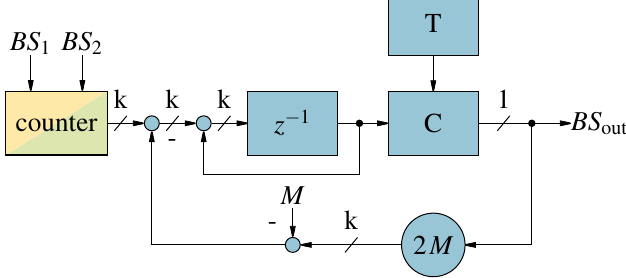
Figure 10. First order Counter Based addition of two bit-streams.